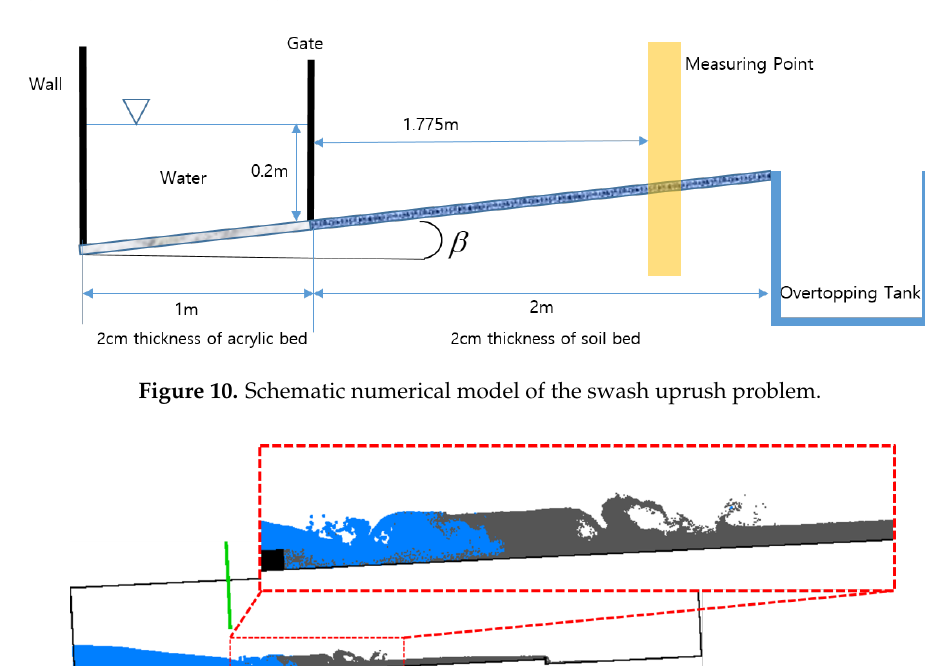
Figure 11. Snapshot of simulation for the swash uprush problem.